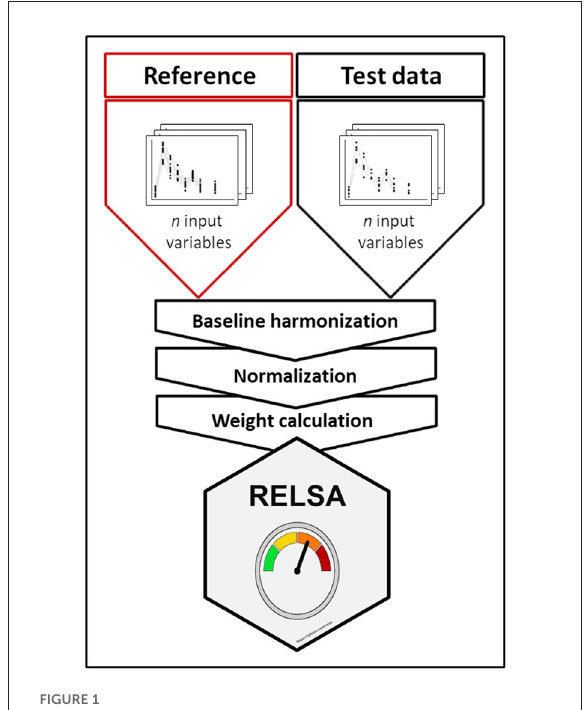
FIGURE1 Graphical representation of the RELSA procedure. RELSA requires a reference set that provides qualitative severity context to the quantitative RELSA comparisons. Thus, independent test data can be related to the reference set, enabling an objective relative severity grading of individual animals, subgroups, and models. Before the data can enter the RELSA procedure, the pipeline requires a baseline harmonization so that changes are always relative to a starting point. The normalization to the baseline enables the calculation of the RELSA weights (RW), which are expressions of similarity to the reference set and must be defined with a fixed number of input variables. Later, any number of these variables in the test data can be quantitatively